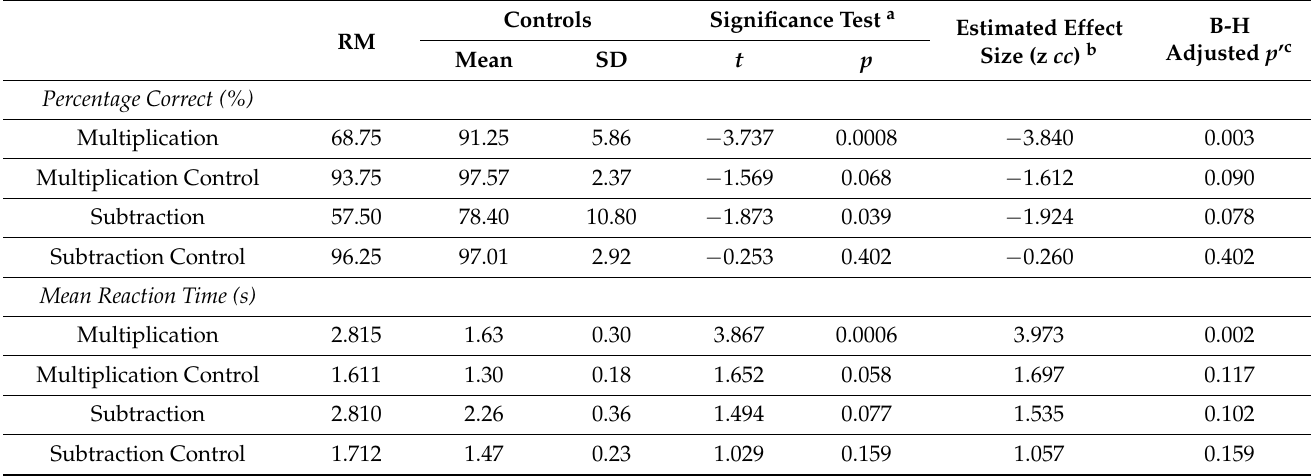
Table 2. Behavioral results for multiplication, subtraction and control tasks for RM and controls.